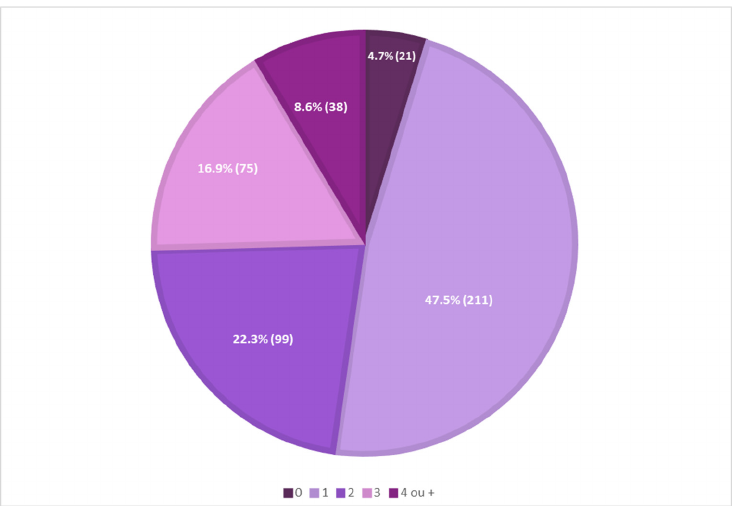
Figure 1. Analysis of the presence of antioxidants in 444 sunscreen formulations.